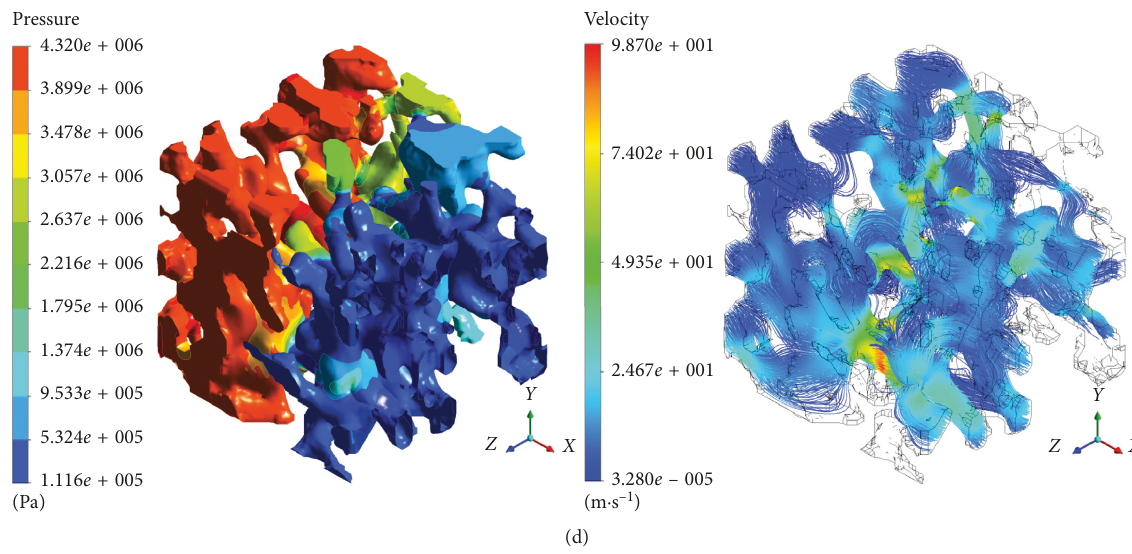
Figure 19: Distribution of pressure and velocity fields in four different models under a low inlet pressure of 4.3MPa. (a) Results in model P (b) Results in model P 2 . (c) Results in model P 3 . (d) Results in model P 4